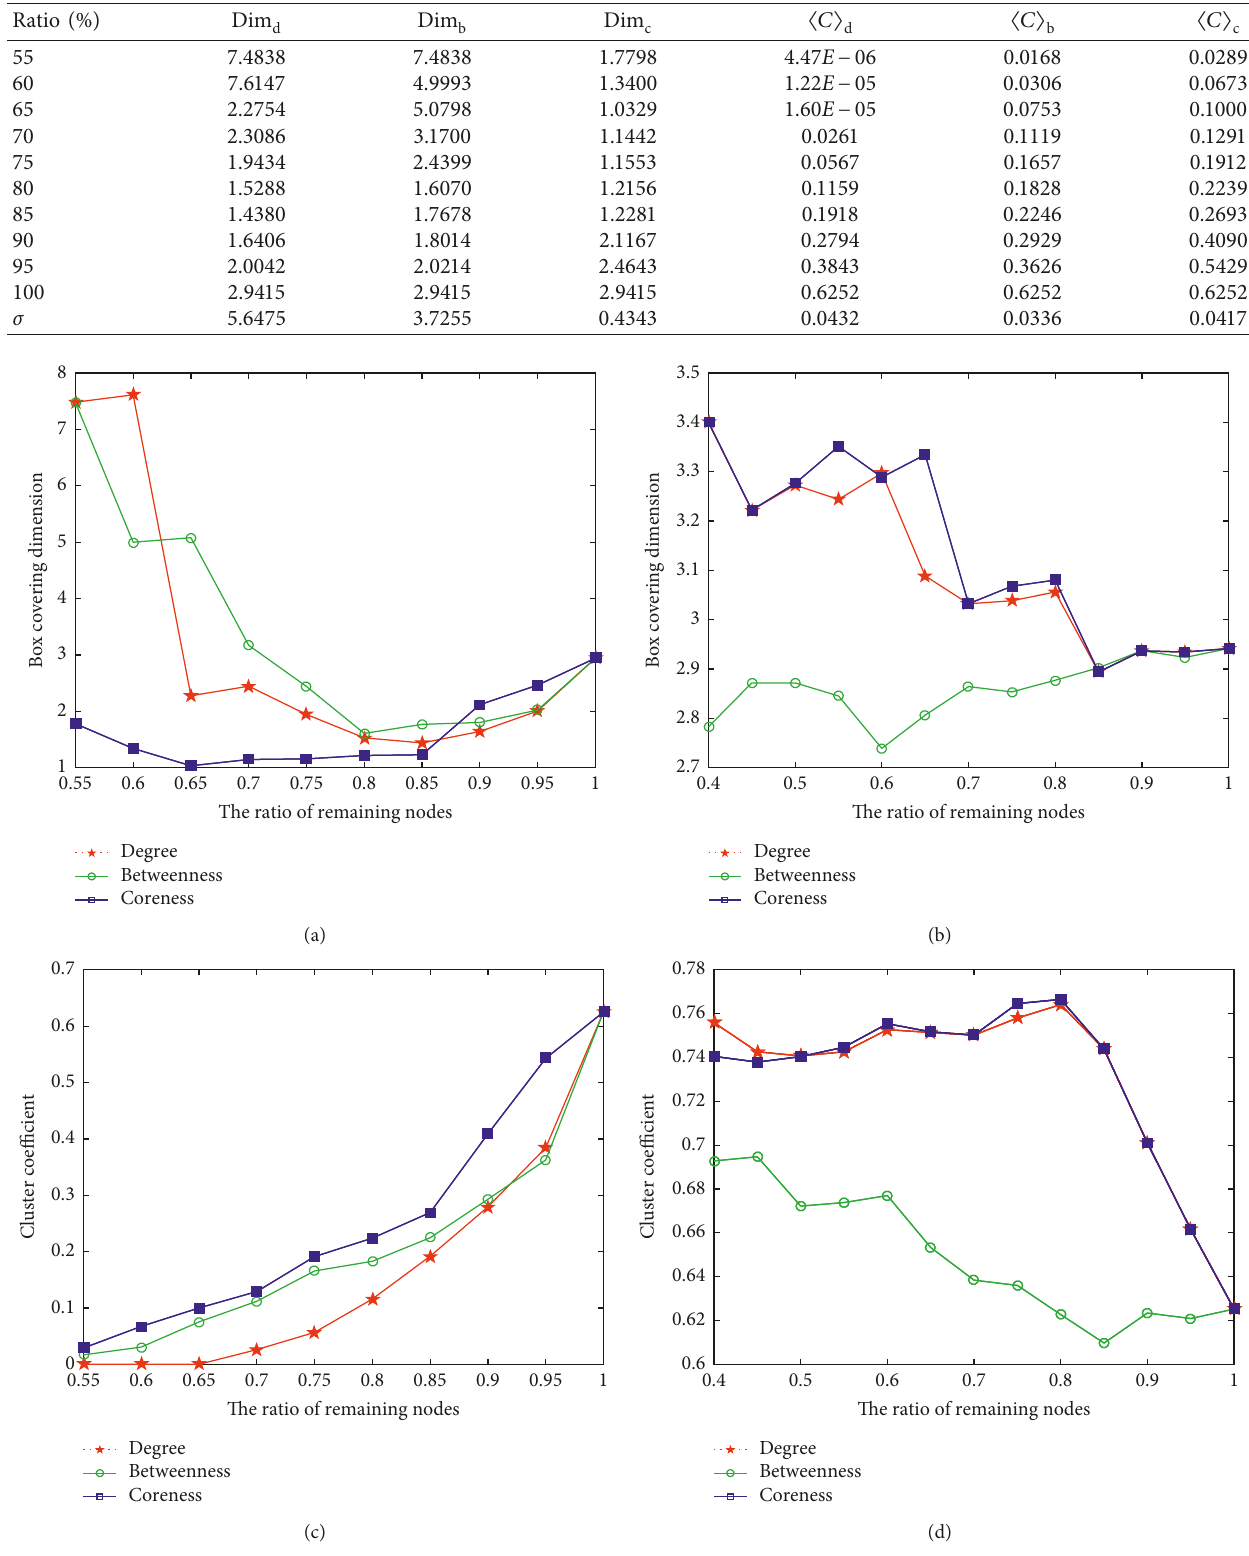
Table 4: Changes of box dimension and cluster coefficient of USAir network with nodes removal in the descending order.